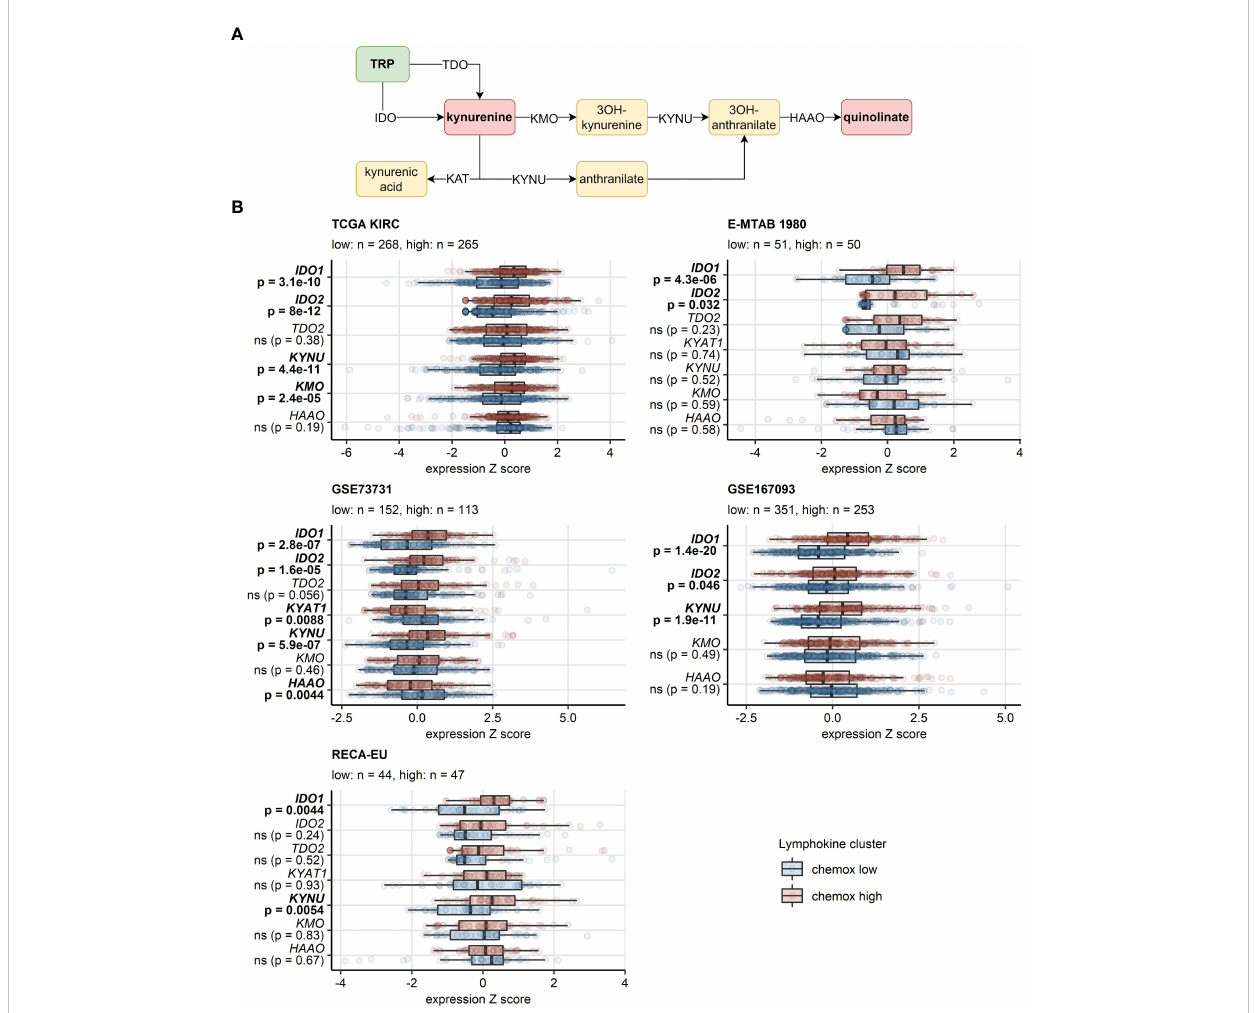
FIGURE 10 Differential expression of genes involved in the tryptophan/kynurenine/quinolinate metabolism between the two chemokine clusters. Genes differentially expressed in chemokine (chemox) high versus chemokine low RCCs were identi fi ed by false discovery rate (FDR) corrected two-tailed T test. Results for genes involved in the tryptophan - kynurenin - quinolinate metabolic pathway are presented. (A) Pathway scheme. TRP, tryptophan; TDO, tryptophan 2,3-dioxygenase; KMO, kynurenine 3-monooxygenase; KYNU, kynureninase; KAT, kynurenin aminotransferase; HAAO, 3- hydroxyanthranilate 3,4-dioxygenase. (B) Gene expression in the clusters. Median normalized log 2 expression levels with interquartile ranges (IQR) are presented as boxes, whiskers span over the 150% IQR. Points represent single cancer samples. P values are indicated in the Y axes, signi fi cant effects are highlighted in bold. Numbers of cancer samples assigned to the chemokine high and low clusters are displayed in the plot captions.